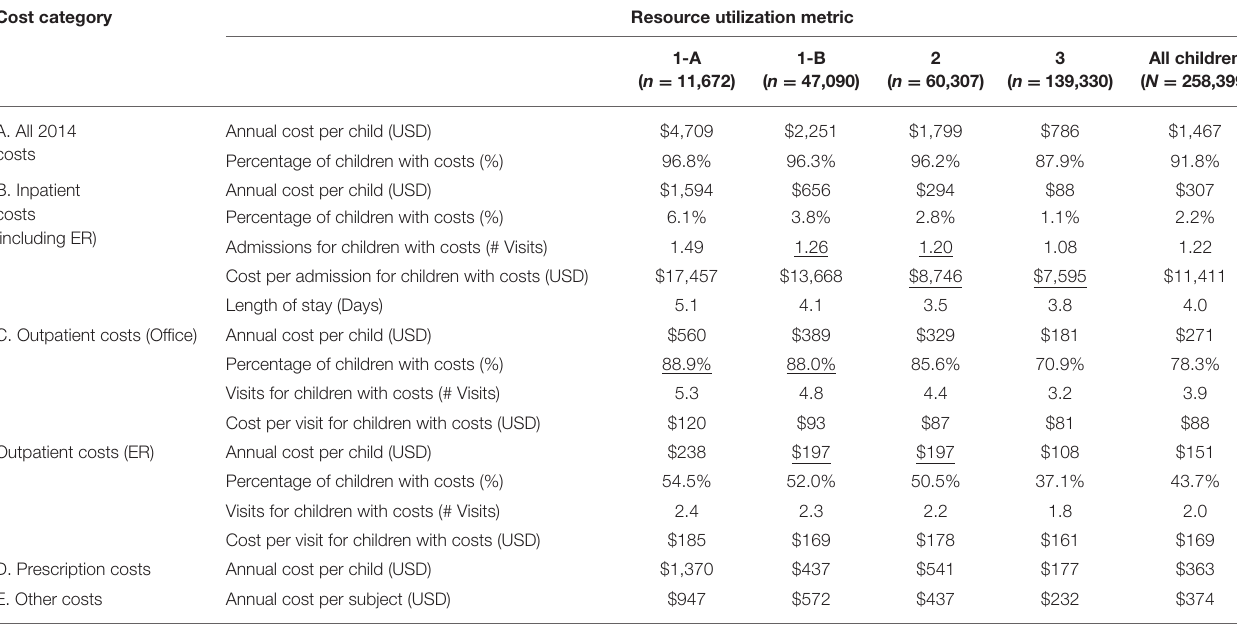
TABLE 3 | Summary of annual costs and healthcare utilization.